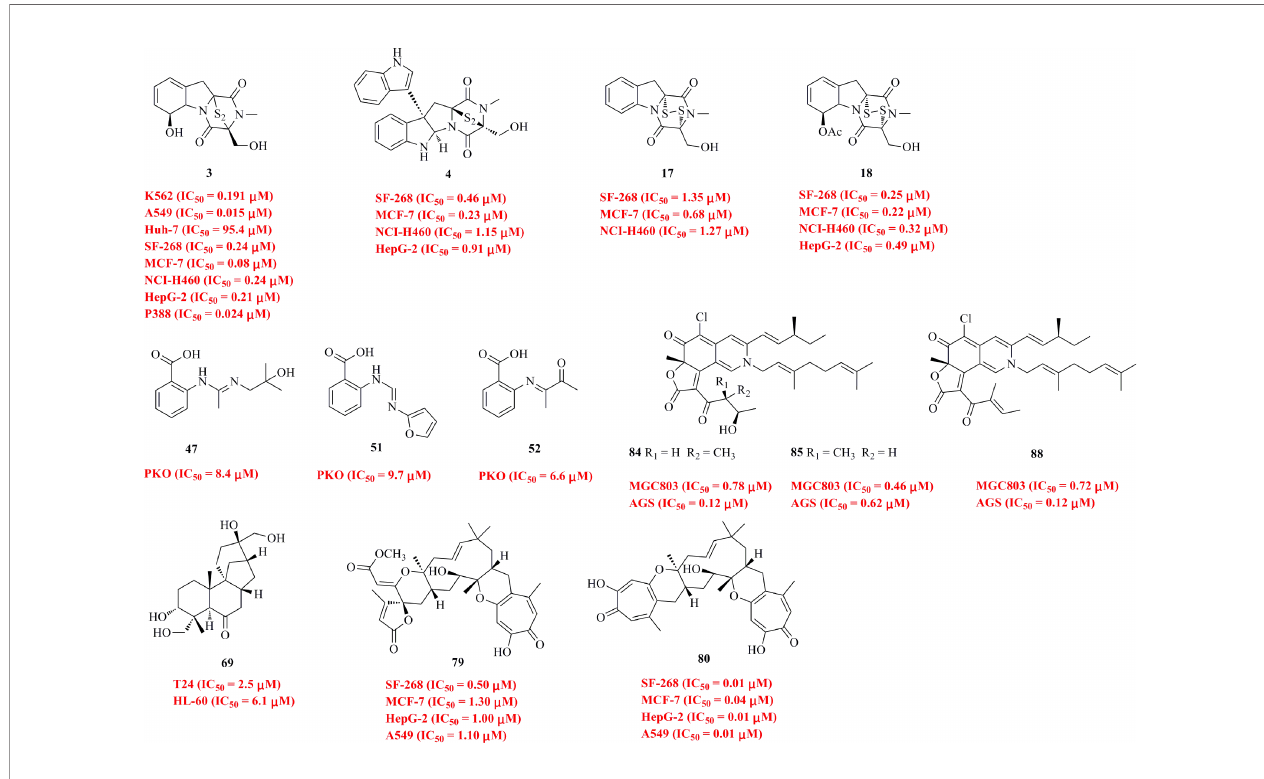
FIGURE 14 | Some “ star molecules ” with high drug leads potential.